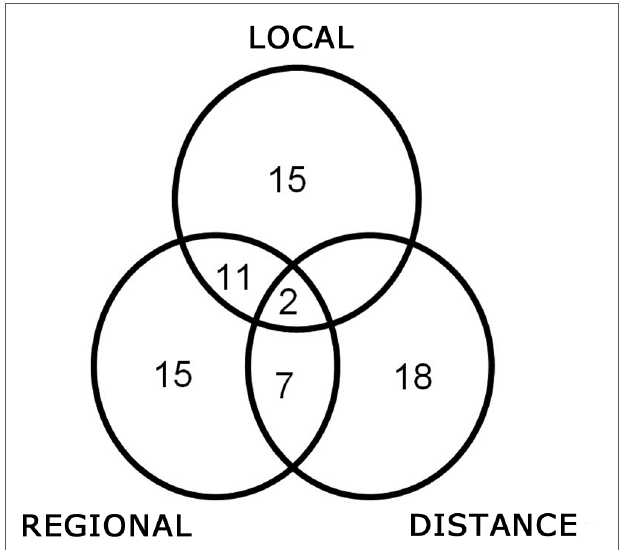
Figure 1. Recurrence of hypopharyngeal squamous cell carcinoma. Cervical control was 72%; overall 5-year survival was 28% (Fig.